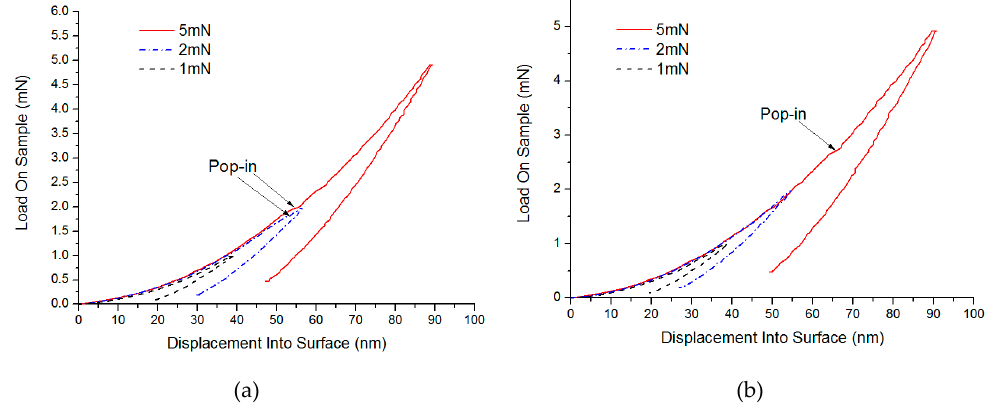
Figure 4. Test results of Single crystal 6H-SiC substrates under small loads ( a ) Load and depth curve in small loads of C face and ( b ) Load and depth curve in small loads of Si face.